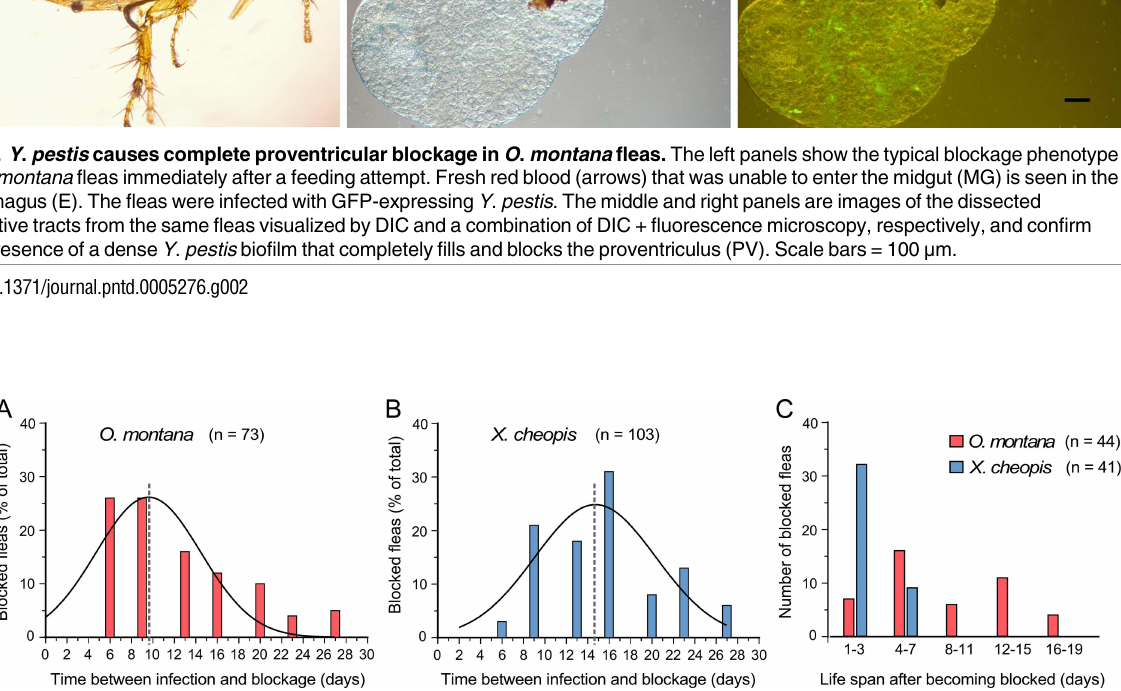
Fig 3. O . montana blocks earlier and surviveslonger after becoming blocked than X . cheopis . Histograms of the temporal incidenceof complete blockagein O . montana and X . cheopis ( A , B ) and their life span after becomingblocked ( C ). Dashedlines indicatethe mean; curve fitting used a Gaussianmodel of the frequencydistributiondata. Blocked O . montana survived significantly longerthan blocked X . cheopis ; P < 0.0001 by log-rank(Mantel-Cox) test.